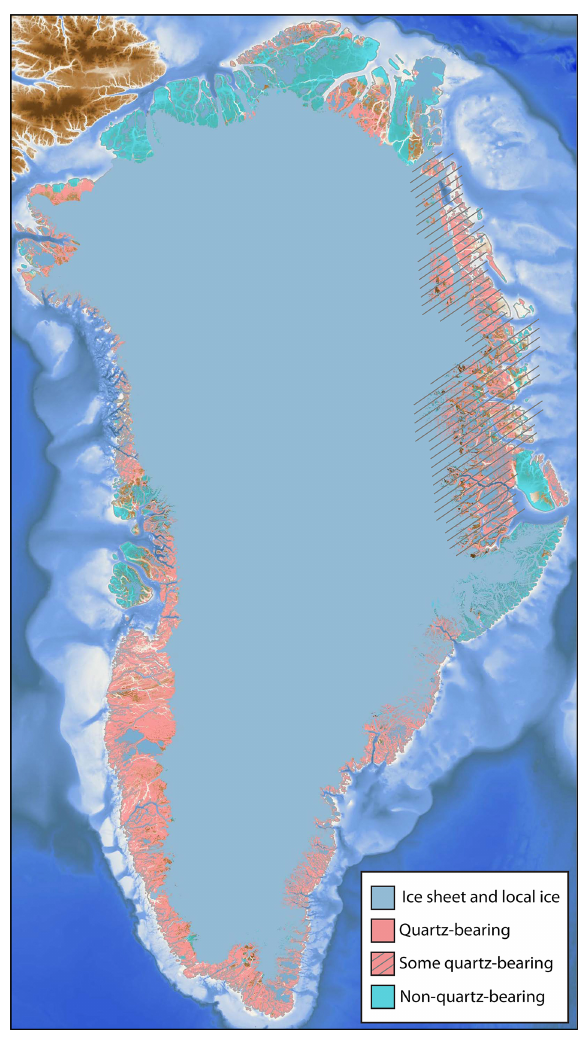
Figure 4. Simplified bedrock geology map of Greenland, show- ing lithology sub-divided into probably quartz-bearing rocks, some quartz-bearing lithologies and probably non-quartz-bearing rocks. From https://www.greenmin.gl/. Basemap topography and bathymetry from Morlighem et al.